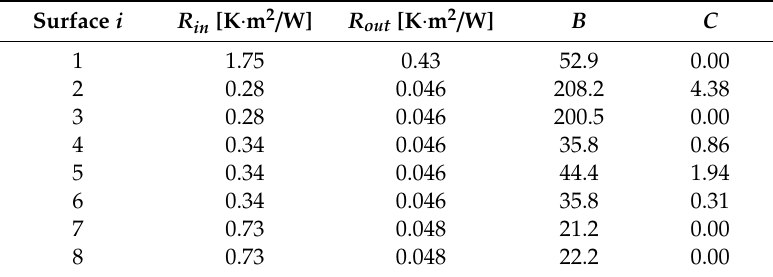
Table 3. Values of constants B and C for each surface